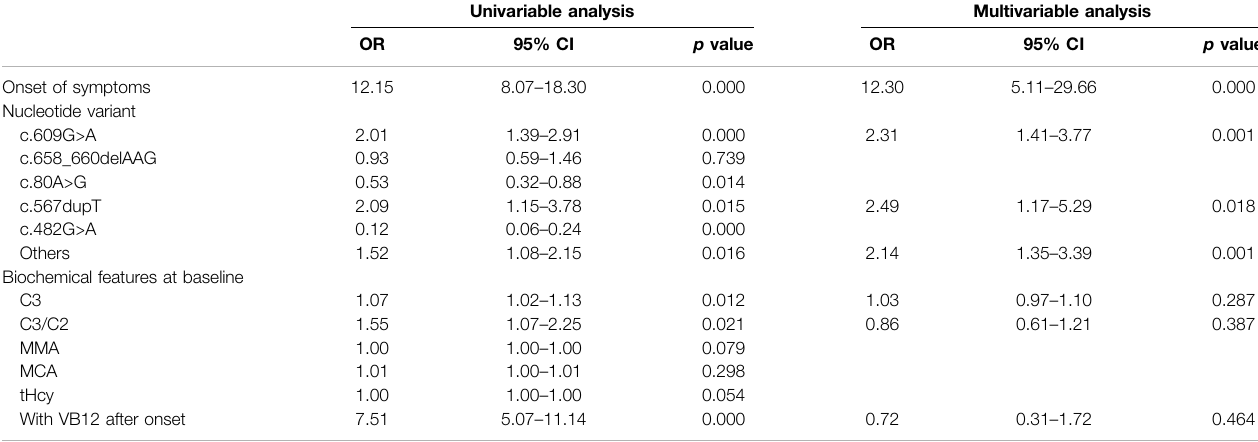
TABLE 4 | Univariate and multivariate analysis of predictors for intellectual impairment.